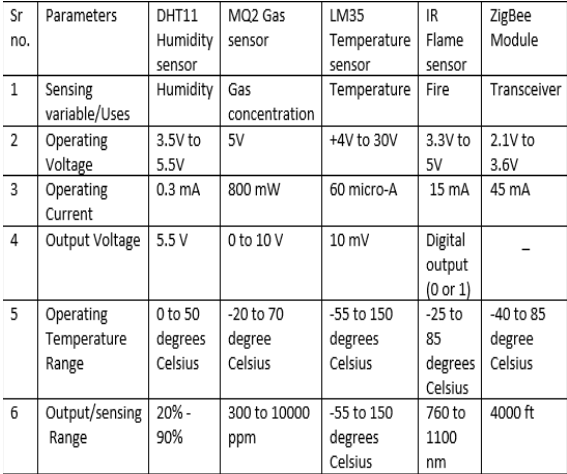
Table 1 : Specification table for selected sensors